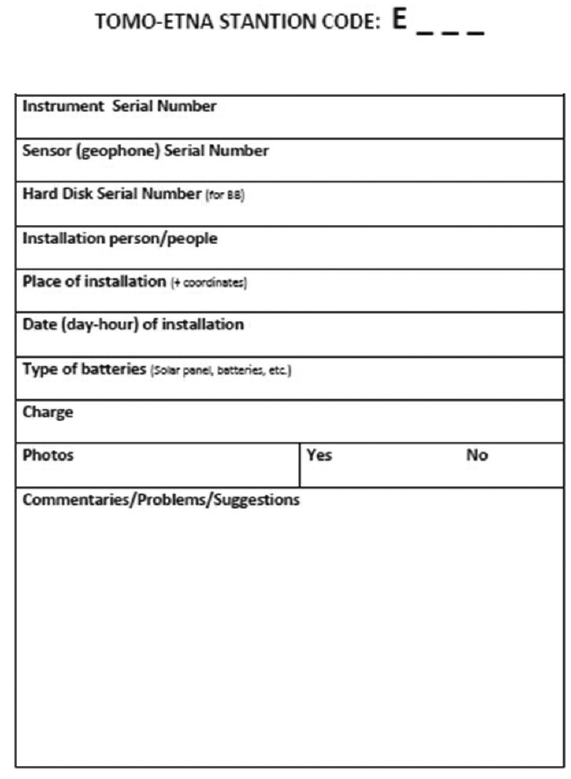
Figure 16. An example of the technical sheet that had to be com- piled for each seismic station.